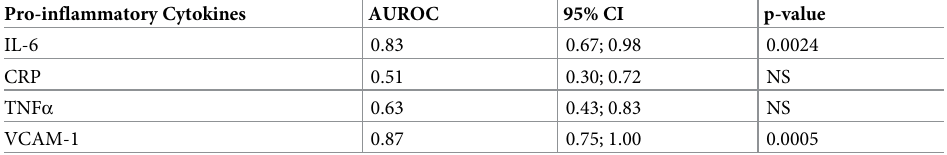
AUROC, area under the receiver operating curve; CI, confidence intervals; NS, not statistically